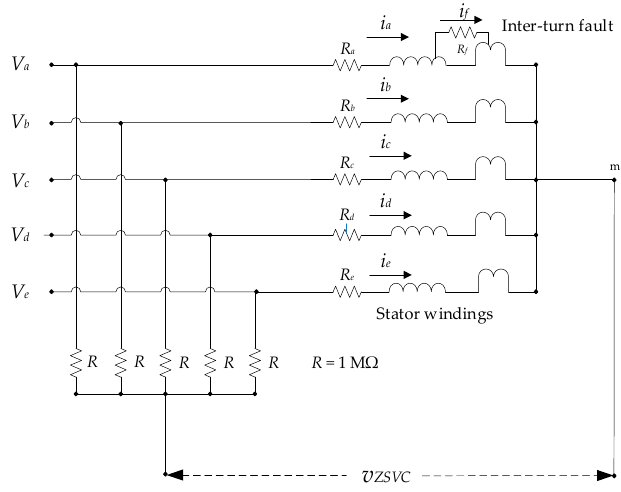
Figure 4. Measurement of the zero-sequence voltage component (ZSVC) by means of five identical resistors used to produce an artificial neutral voltage.